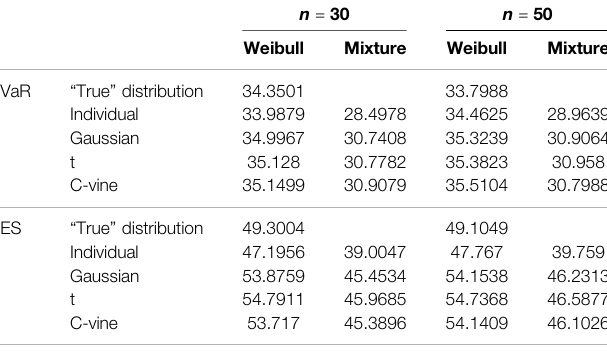
TABLE 11 | The average VaR and ES of aggregate losses for states in Group 2.